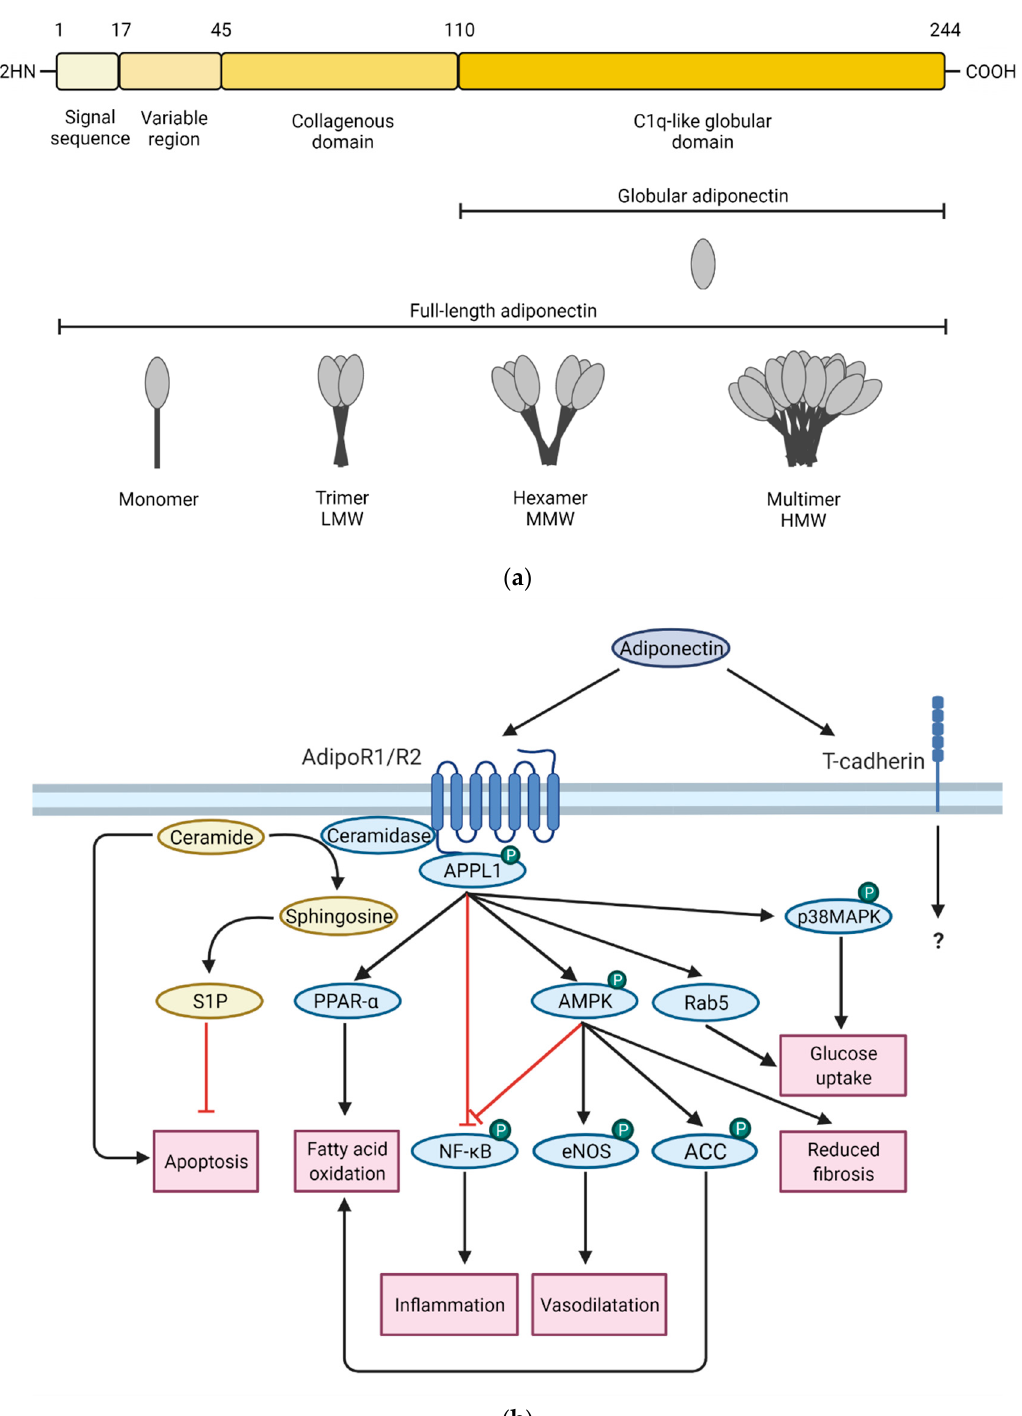
Figure 2. ( a ) Adiponectin structure and isoforms. ( b ) Simplified adiponectin downstream signaling . ACC: Acetyl-CoA carboxylase, AMPK: AMP-activated protein kinase, APPL1: adaptor protein, phosphotyrosine interacting with PH domain and leucine zipper 1, eNOS: Endothelial NOS, NF- Κ b: Nuclear factor- κ B, p38MAPK: p38 mitogen-activated protein kinase, PPAR- α : Peroxisome proliferator-activated receptor α , S1P: sphingosine-1-phosphate.